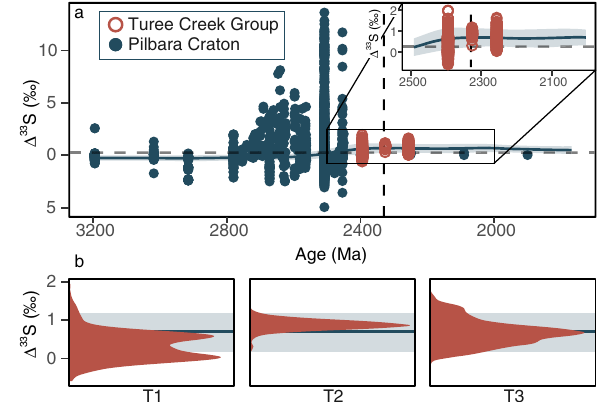
Fig. 4 | Simulations of the crustal memory effect (CME) within a hypothetical partially hydrographically restricted basin adjacent to the Pilbara Craton. a Here, the blue line indicates the simulated Δ 33 S evolution of the Pilbara-speci fi c weathering fl ux, with its associated envelope capturing the 1 σ uncertainty. Super- imposed on these, the available Pilbara-derived Δ 33 S data are plotted in blue, while those from the Turee Creek Group are distinguished as red open symbols 32 . The vertical dashed line marks the Great Oxidation Event(GOE) sensu Luo et al. 22 , while the horizontal dashed line represents the globally expressed CME modelled using the CA dataset (Fig.3b).The 2500 – 2000Maexpansion (insert)follows ( a ). b Core- speci fi c density distributions of the Δ 33 S data from the Boolgeeda Iron Formation and Turee Creek Group 32 , younging from left to right (i.e., cores T1 → T3). The hor- izontal blue line and envelope follow ( a